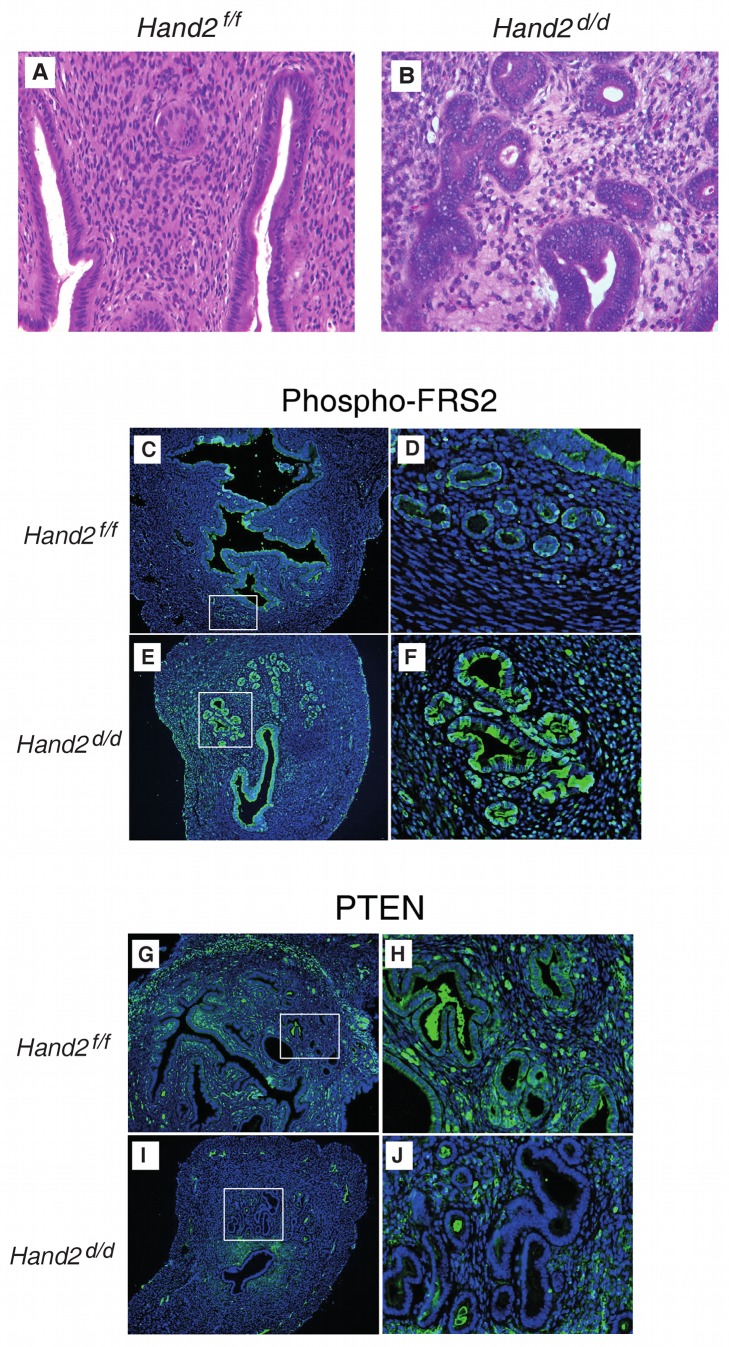
Endometrial pre-invasive neoplastic changes in Hand2 conditional knock-out mice.(A and B) Hematoxylin and eosin staining of uterine sections from Hand2f/f (A) and Hand2d/d (B) mice (n = 5). Representative uterine sections obtained from mice at 24–48 wk of age are shown. Closely packed, irregular-shaped glands and features consistent with CAH are evident in uteri lacking Hand2. Note multiple layers of glandular epithelium in Hand2d/d uteri. Magnification 40×. (C–F) Phospho-FRS2 immunofluorescence in sections from Hand2f/f (C) (boxed region in [C] further magnified in [D]) and Hand2d/d (E) (boxed region in [E] further magnified in [F]) mice (n = 3). Magnification 20× (C and E) and 40× (D and F). (G–J) PTEN immunofluorescence in sections from Hand2f/f (G) (boxed region in [G] further magnified in [H]) and Hand2d/d (I) (boxed region in [I] further magnified in [J]) mice. Magnification 20× (G and I) and 40× (H and J) (n = 3).